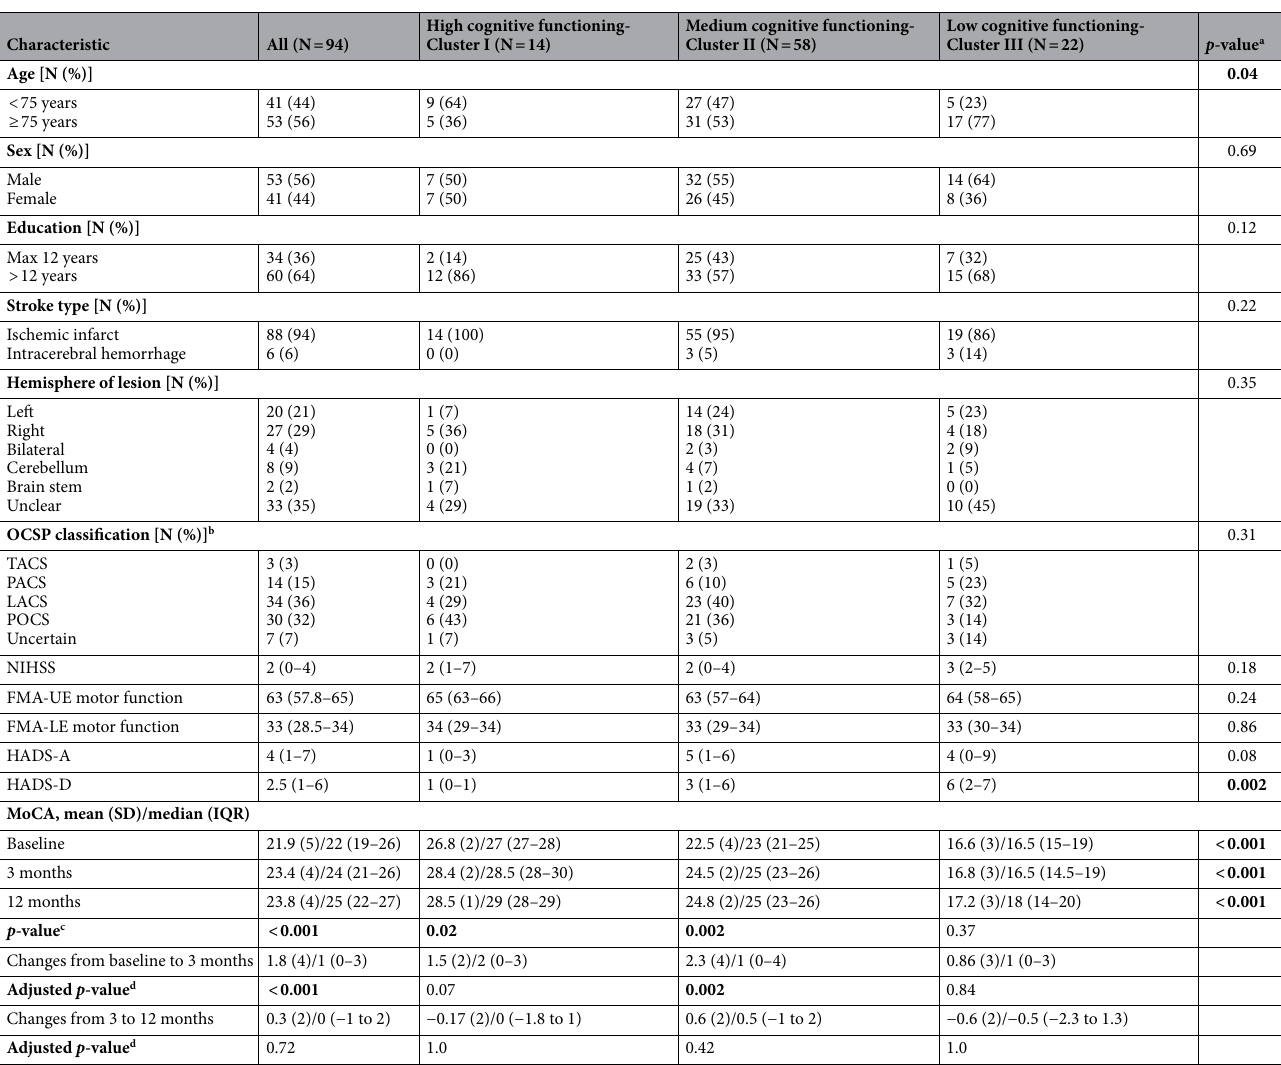
Table 1. Clinical assessments and self-reported measures between the identified trajectory groups. Data are given as median (IQR) unless otherwise noted. IQR interquartile range, SD standard deviation, NIHSS